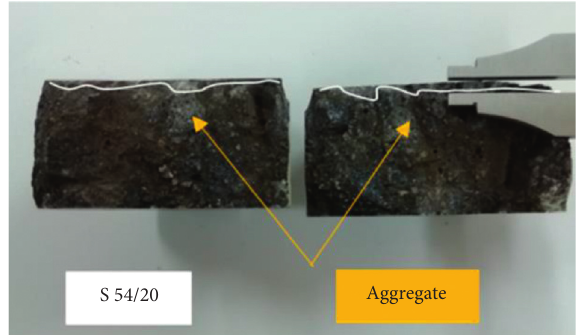
Figure 10: Chloride ions’ migration front for S